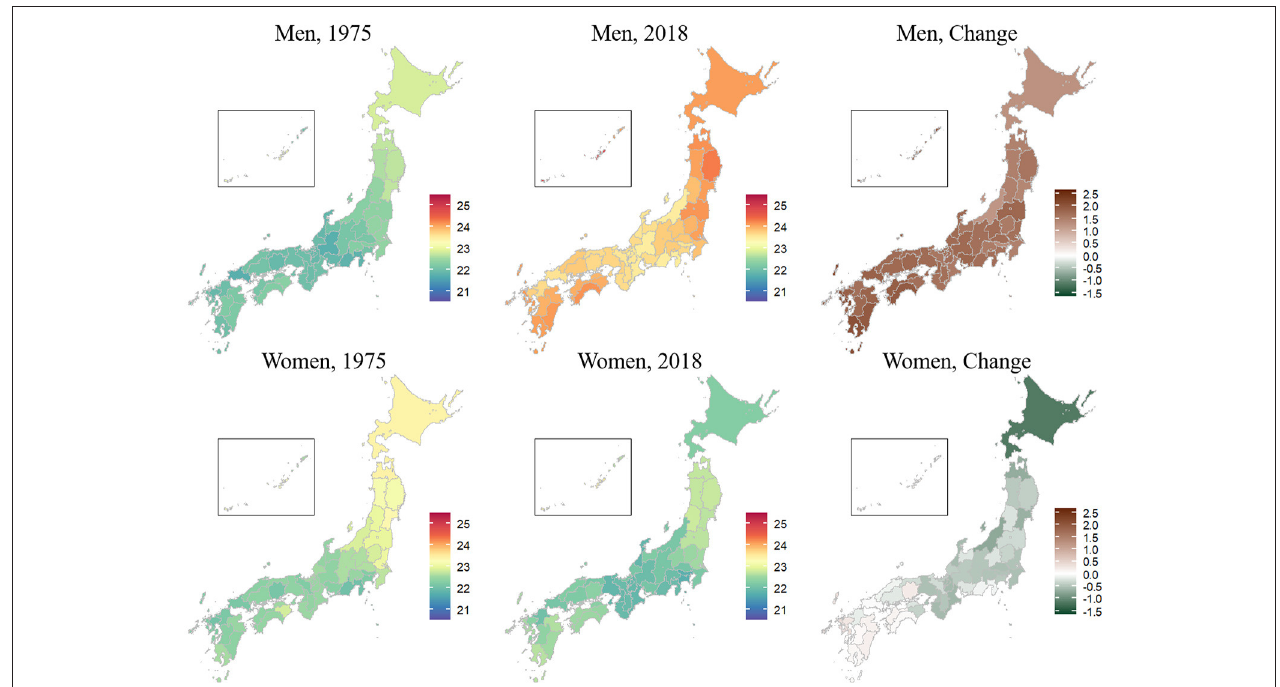
FIGURE 2 | Geography of the age-standardized prefectural mean body mass index (kg/m 2 ) in 1975 and 2018 and its changes among adults aged 20–79 years in the 47 prefectures of Japan, by sex. The prefectural mean body mass index was estimated using a Bayesian spatiotemporal model. The insets are enlarged views of Okinawa.